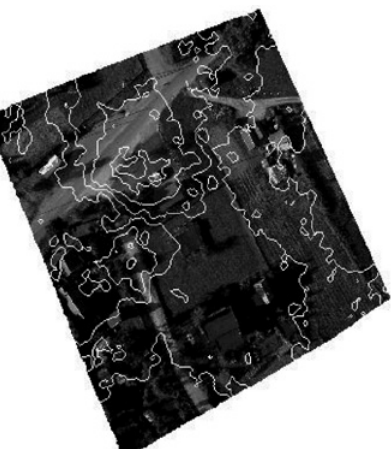
Fig. 9. Ortho-photo with overlaid contour lines